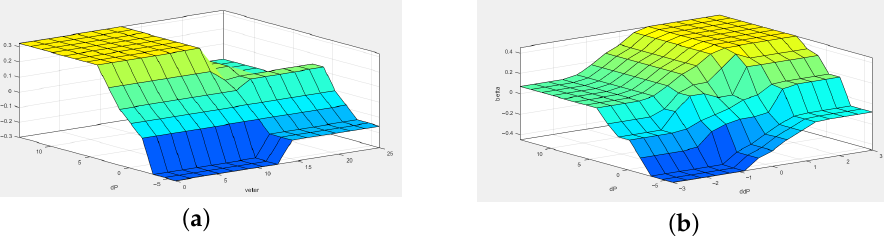
Figure 12. The surface of the algorithm defuzzification results depends on: ( a ) power deviation, pitch angle and wind speed; ( b ) pitch angle, power deviation and power deviation